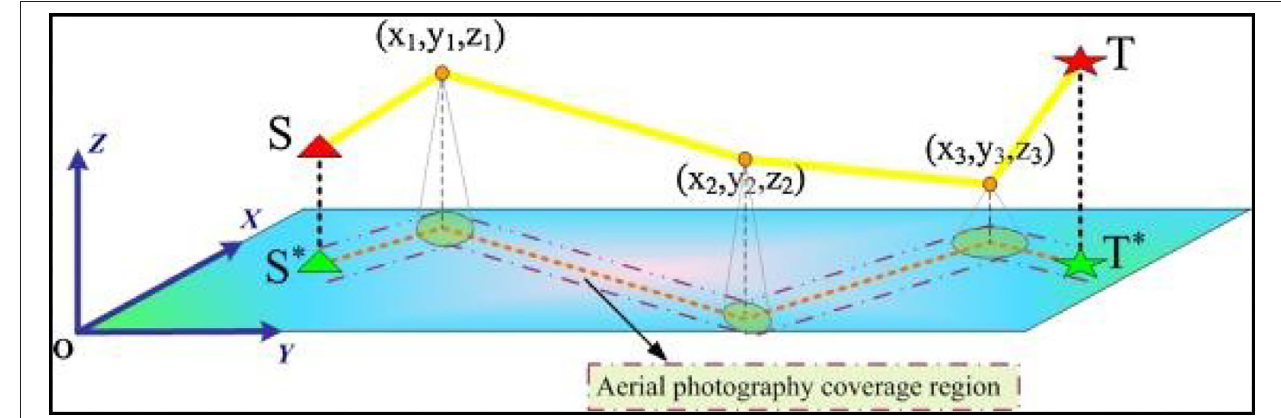
FIGURE 1 | UAV flight